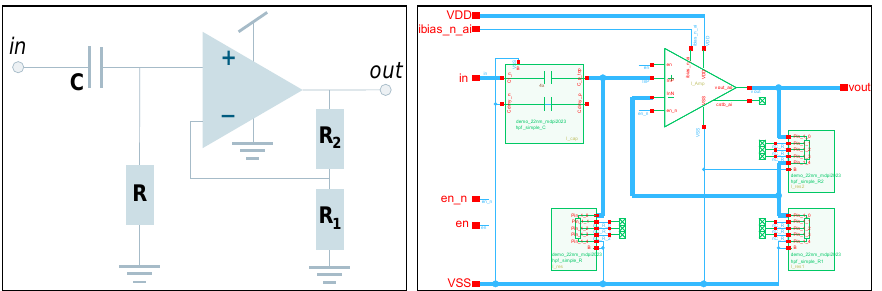
Figure 7. Topology of the simple high-pass filter (HPF) consisting of an amplifier, resistors, and a capacitor. The block diagram is depicted on the left and the corresponding schematic diagram (vector graphic which is derived from the actual design view), that includes generated building blocks for both amplifier and the passives, is shown on the right.